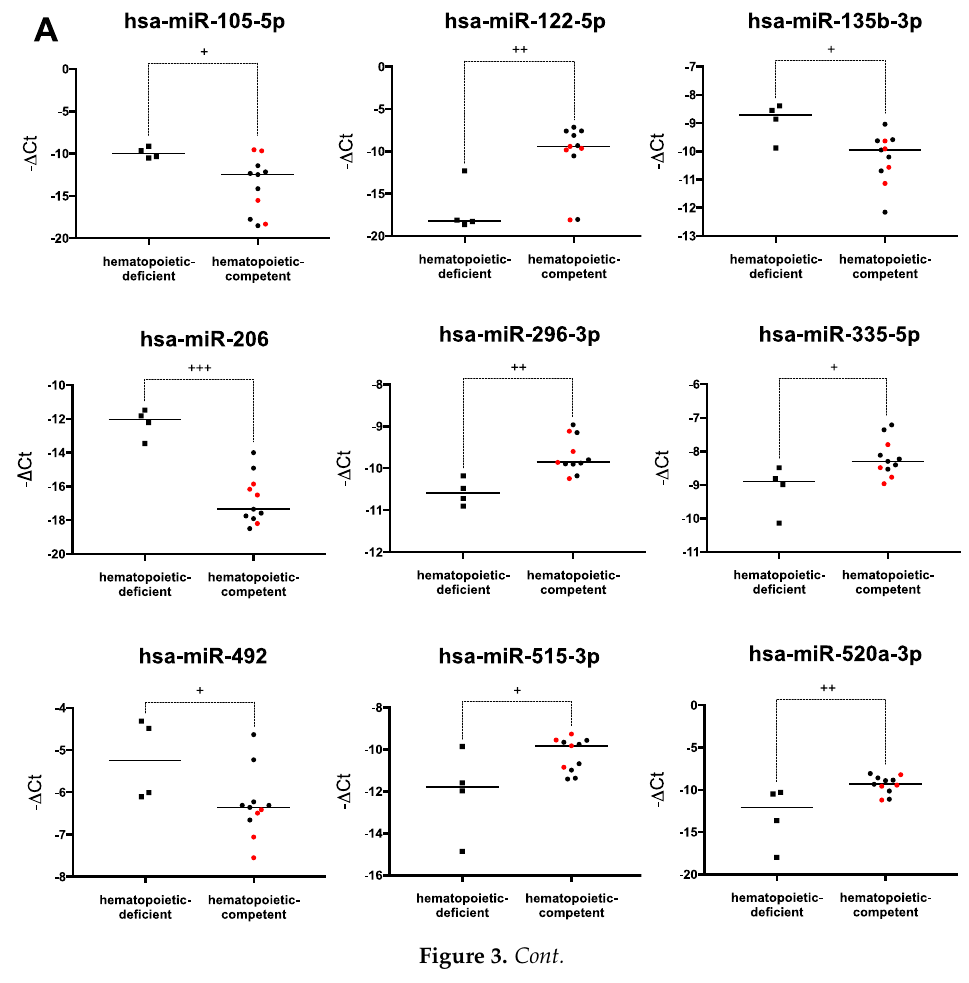
Figure 3. Figure 3. Cont.